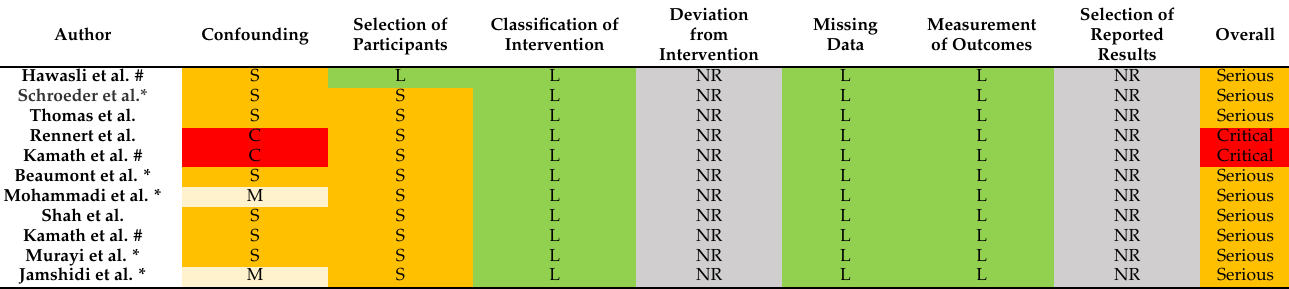
Table 1. Risk of bias according to the ROBINS-I tool.